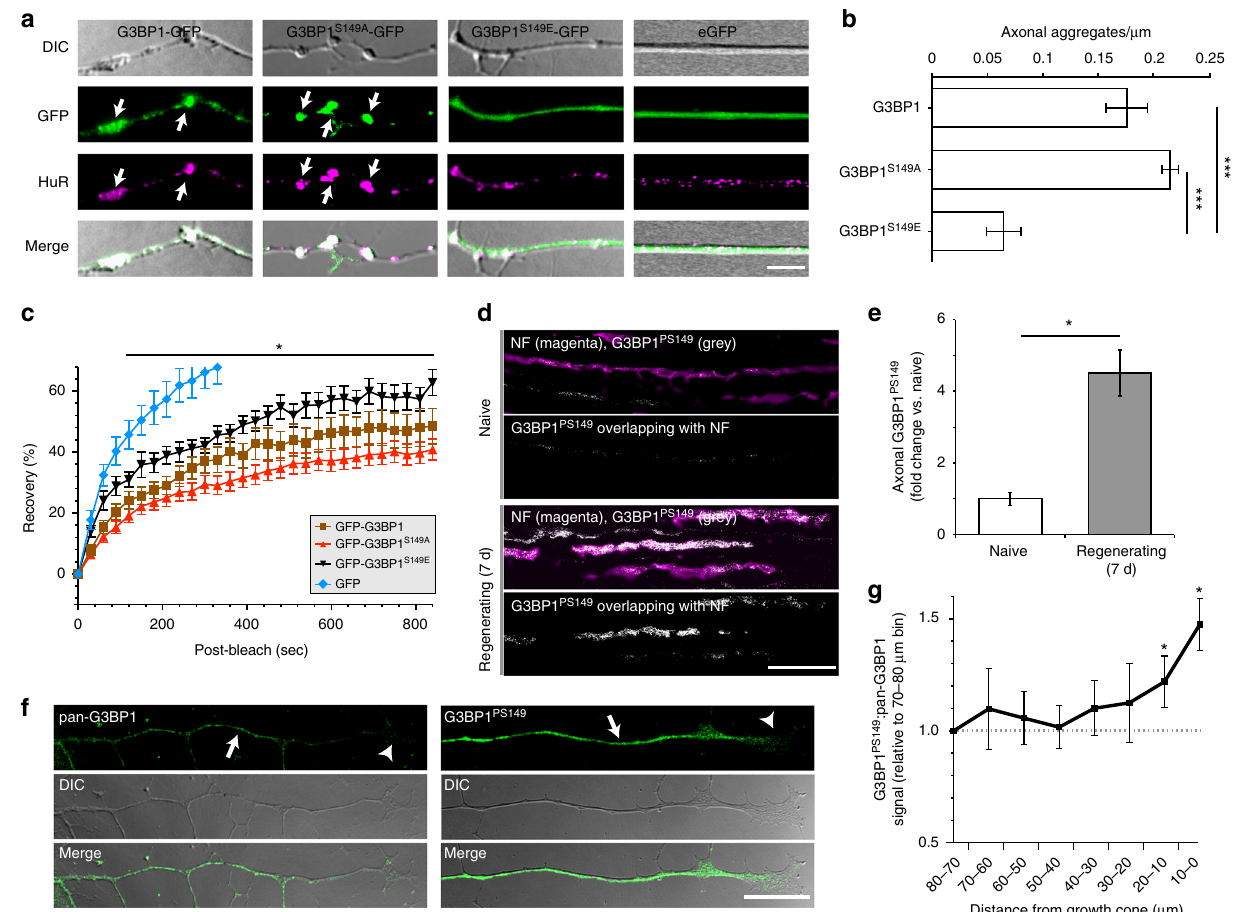
Fig. 2 G3BP1 is phosphorylated in regenerating axons. a Representative images for axons of DRG neurons transfected with indicated G3BP1 constructs vs. eGFP are shown. G3BP1-GFP and G3BP1 S149A -GFP show prominent aggregates in axons that colocalize with HuR (arrows). In contrast, axonal signals for G3BP1 S149E -GFP and eGFP appear diffuse [scale bar = 5 µ m]. b Quanti fi cation of axonal aggregates for G3BP1-GFP, G3BP1 S149A -GFP, and G3BP1 S149E -GFP is shown as average ± SEM ( N ≥ 10 neurons over 3 repetitions; *** p ≤ 0.005 by one-way ANOVA with Tukey HSD post-hoc). c FRAP analyses for neurons transfected with constructs as in A are shown as average normalized % recovery± SEM (see Supplementary Fig. 2a for representative FRAP image sequences). G3BP1 S149A -GFP shows much lower recovery than G3BP1 S149E -GFP; G3BP1-GFP is intermediate between G3BP1 S149A -GFP and G3BP1 S149E -GFP ( N ≥ 13 axons over 3 repetitions; * p ≤ 0.05 between G3BP1 S149A -GFP vs. G3BP1 S149E -GFP by one-way ANOVA with Tukey HSD post-hoc). Only the 0 – 320 s. recovery signals for GFP are shown (at 840 s. GFP showed 85.5 ± 4.7% recovery with p ≤ 0.0001 vs. G3BP1 S149E -GFP by one-way ANOVA with Tukey HSD post-hoc). d – e Exposure-matched confocal images for G3BP1 PS149 and NF are shown for sciatic nerve ( d ) as in Fig. 1e. There is a striking increase in G3BP1 PS149 immunoreactivity in the regenerating axons. Quanti fi cations of these signals are shown as mean ± SEM ( e ; N = 3; * p ≤ 0.05 by one-way ANOVA with Tukey HSD post-hoc) [scale bar = 20 µ m]. f – g Distal axons of cultured DRGs immunostained with pan-G3BP1 vs. G3BP1 PS149 antibodies are shown as indicated ( f ). Aggregates of G3BP1 are visible in the axon shaft (arrow), but decrease moving distally towards the growth cone (arrowhead). G3BP1 PS149 signals are fairly consistent and extend into the growth cone (arrowhead). Quanti fi cation of signals ( g ) shows signi fi cant increase in ratio of G3BP1 PS149 immunoreactivity to G3BP1 aggregates moving distally to the growth cone ( N ≥ 9 neurons each over 3 repetitions; * p ≤ 0.05 vs. 70 – 80 µ m